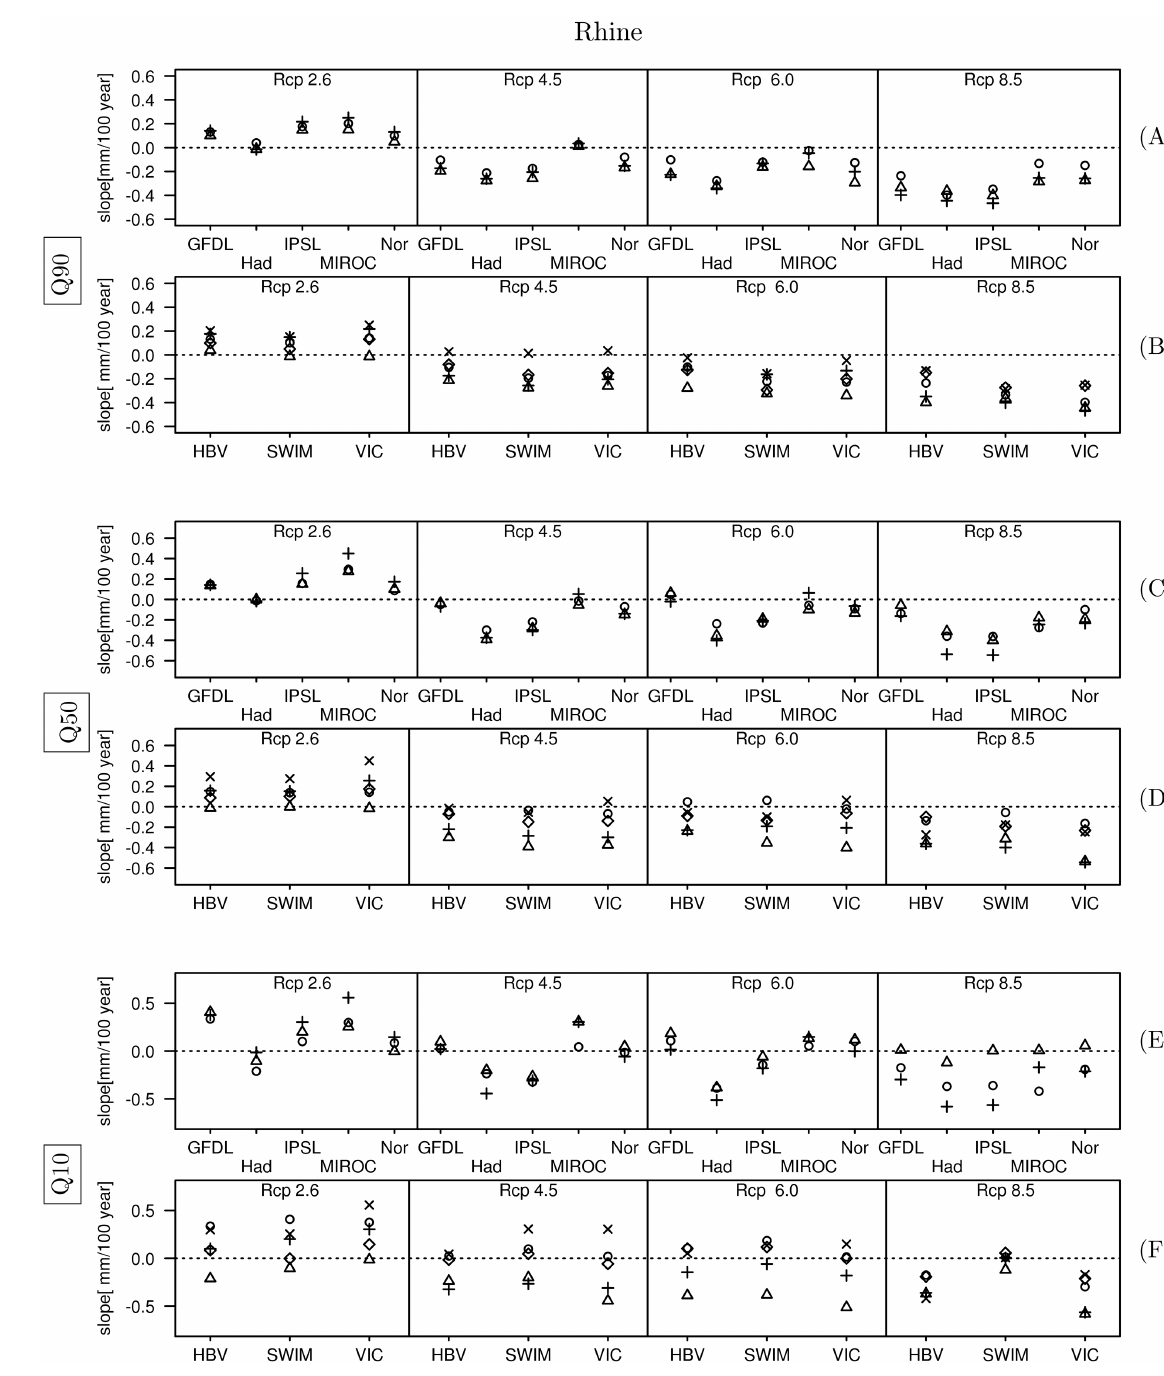
Earth Syst. Dynam., 6, 17–43, 2015